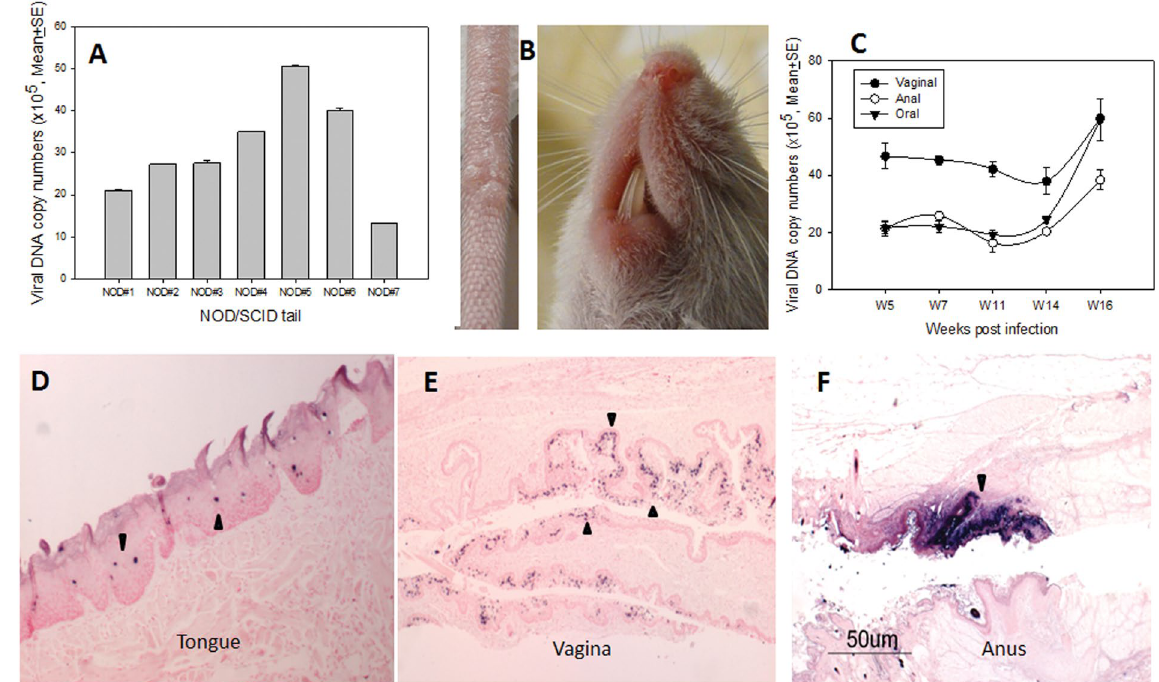
Figure 1. Viral infections were found in NOD/SCID mice at cutaneous and mucosal sites. Viral DNA was detected in infected tail tissues ( A ) even though only one visible lesion was detected on one of the eight tails, and no visible muzzle lesion was found ( B ). Viral DNA was tracked at mucosal sites by measuring DNA in vaginal, anal, and oral lavage samples by Q-PCR ( C ). Viral DNA was further confirmed at the dorsal tongue ( D , 10 × , arrows), the vaginal tract ( E , 10 × , arrows) and the anus ( F , 10 × , arrows) by in situ hybridization.